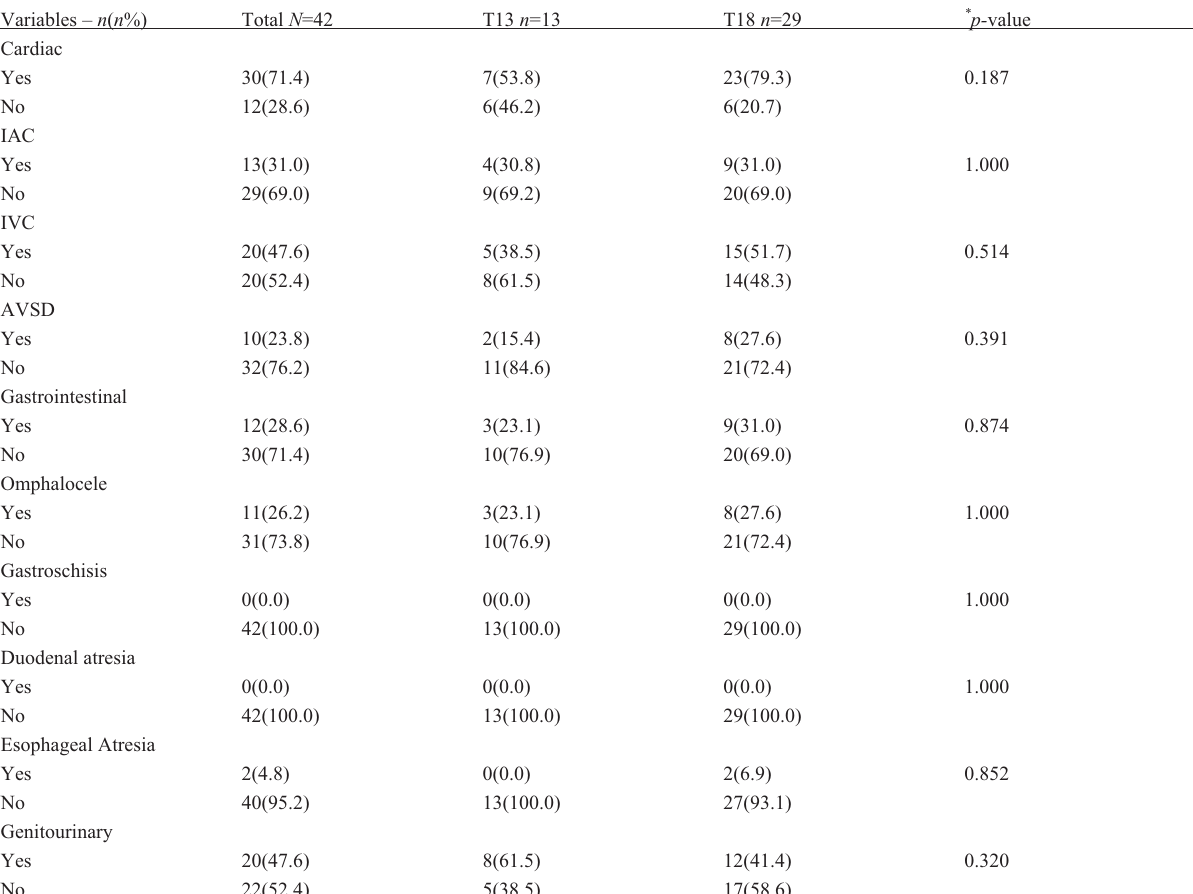
Table 3 - Structural abnormalities for trisomy 13 and trisomy